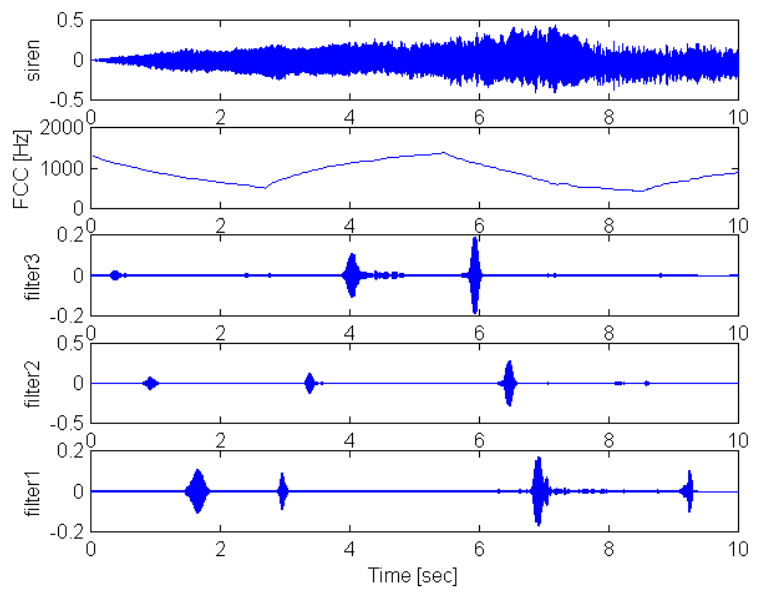
Figure 5. Activation of the three filters for a pure siren signal.